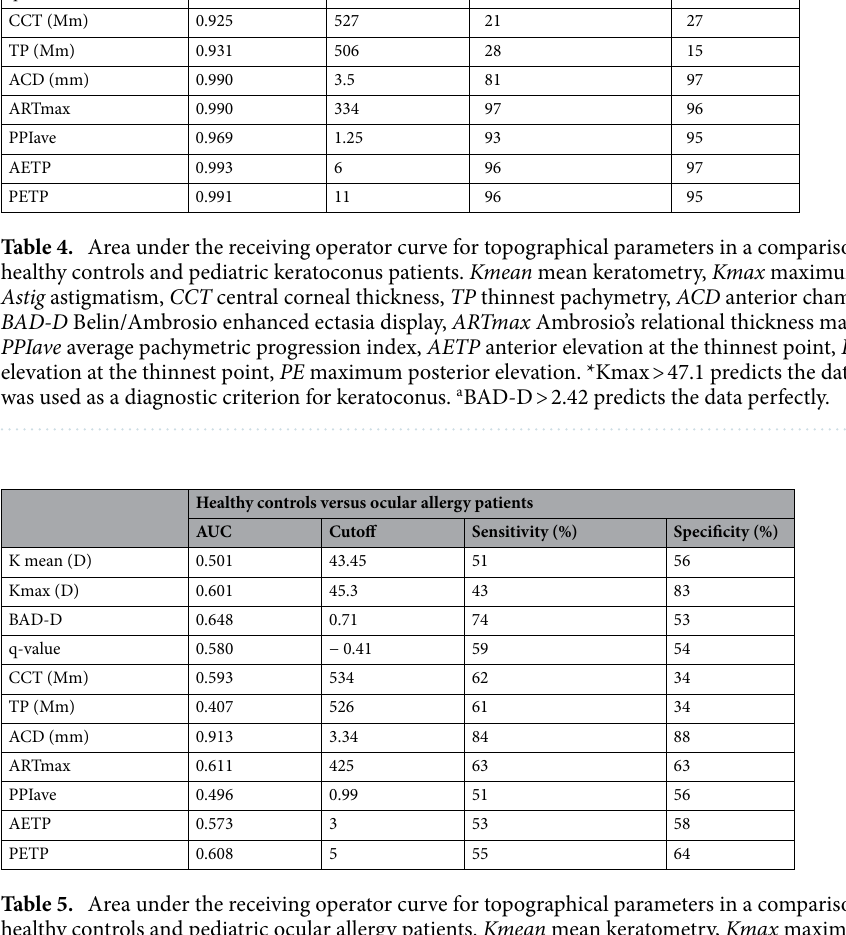
Table 5. Area under the receiving operator curve for topographical parameters in a comparison between healthy controls and pediatric ocular allergy patients. Kmean mean keratometry, Kmax maximum keratometry, Astig astigmatism, CCT central corneal thickness, TP thinnest pachymetry, ACD anterior chamber depth, BAD-D Belin/Ambrosio enhanced ectasia display, ARTmax Ambrosio’s relational thickness maximum, PPIave average pachymetric progression index, AETP anterior elevation at the thinnest point, PETP posterior elevation at the thinnest point, PE maximum posterior elevation.